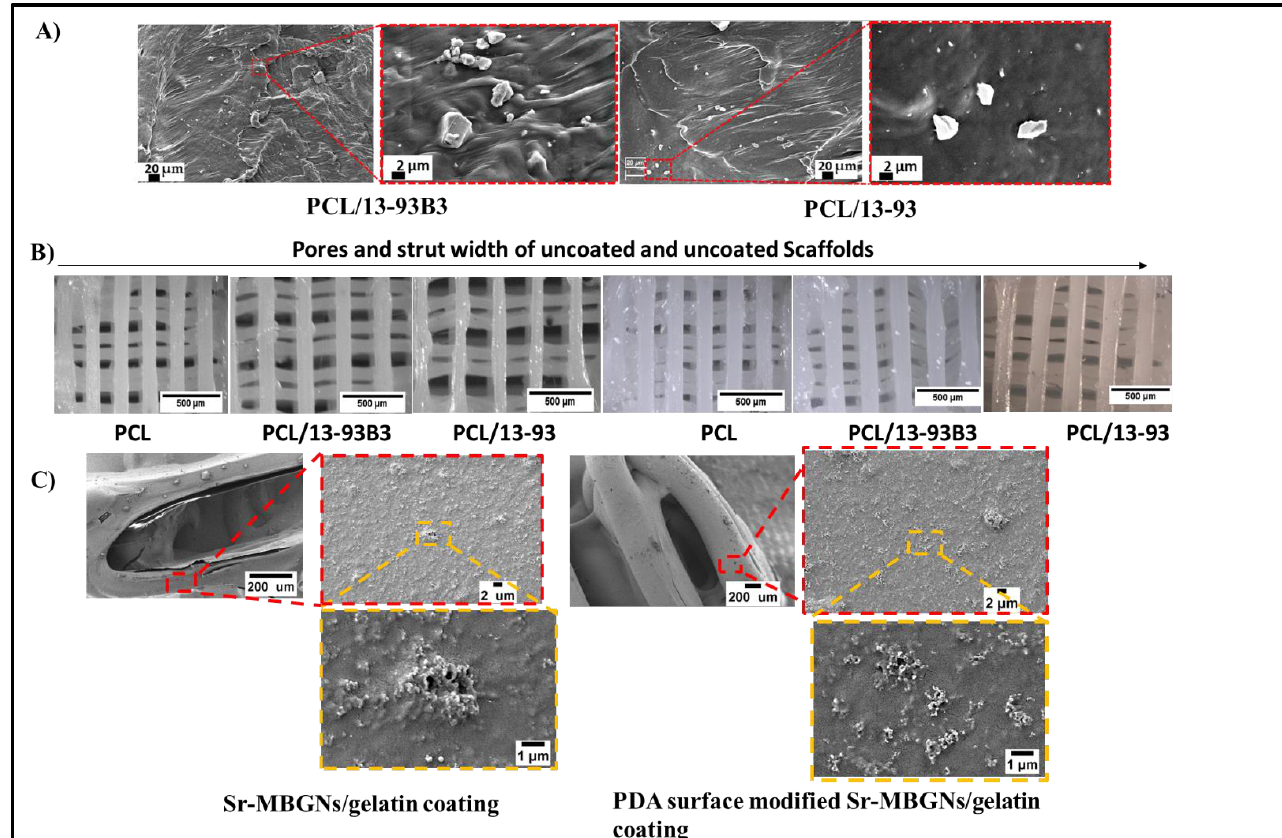
Figure 1. Surface morphology of ( A ) cross-section of filaments via SEM. ( B ) light microscopy images of scaffolds before and after coating. ( C ) SEM images of coated scaffolds at different magnifications highlighted in red and yellow dotted lines. Table 2. Strut width and pore size of uncoated scaffolds (ImageJ).